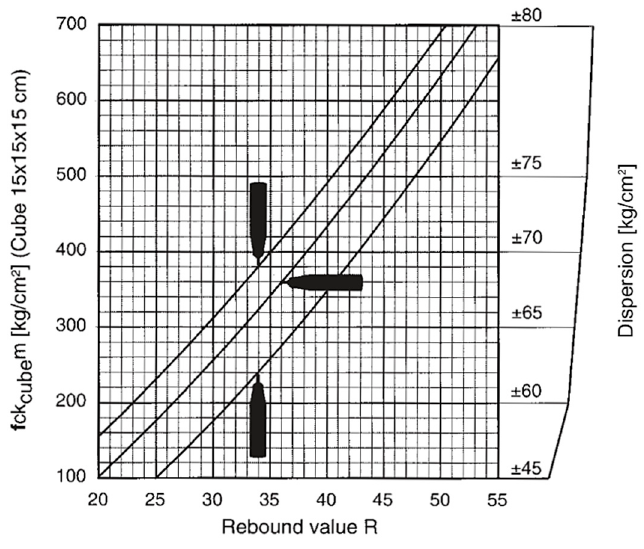
Figure 4 . Characteristic curve for concrete and rebound hammer model: N/NR [11] .